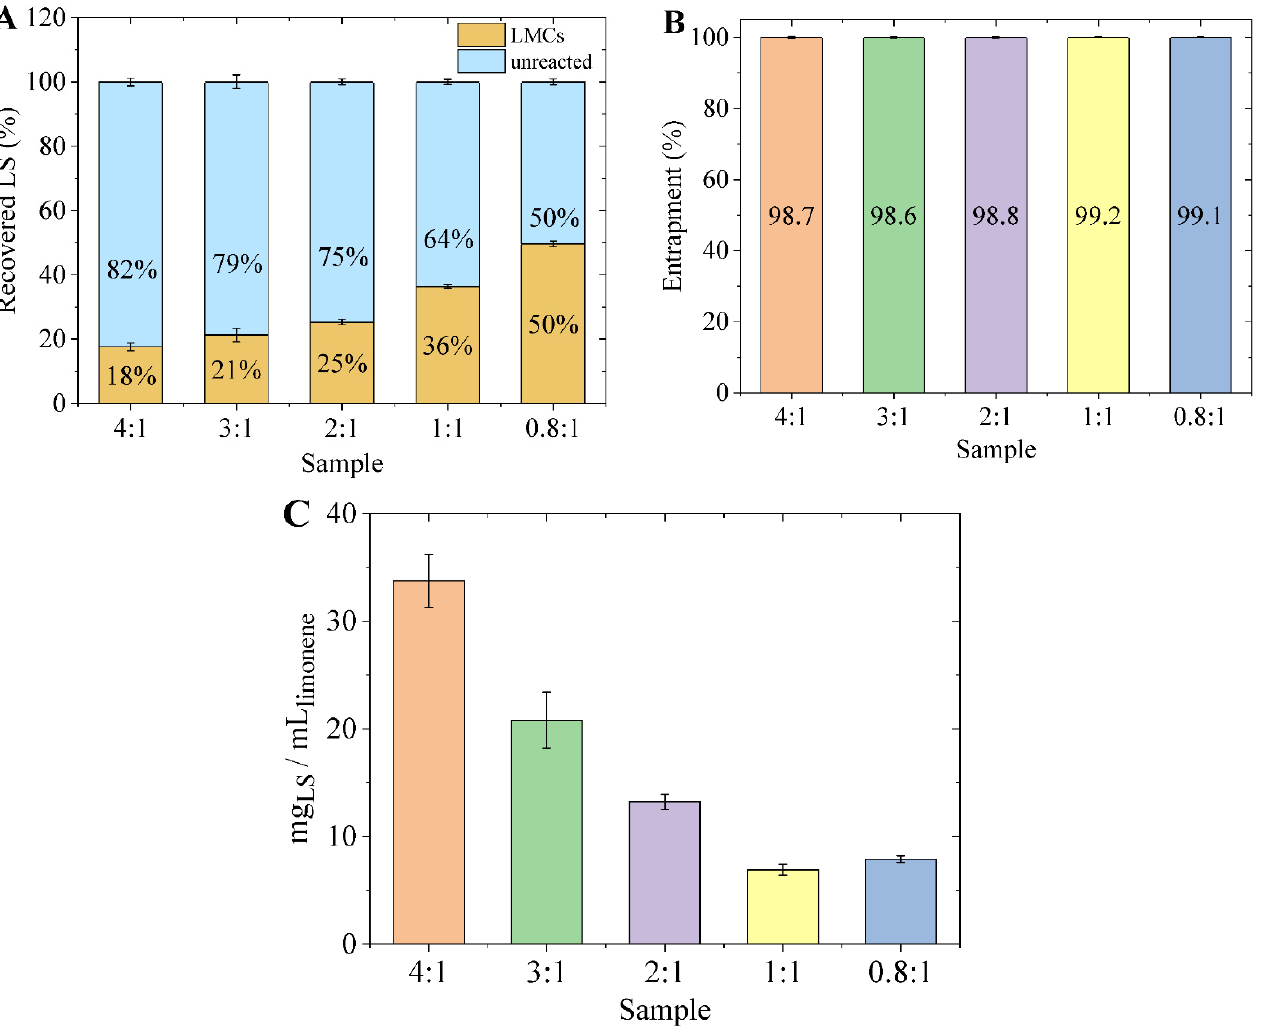
Figure 3. ( A ) Percentage of capsule forming SLS and of unreacted SLS; ( B ) entrapment of limonene in LMCs; ( C ) mass of SLS used per volume of limonene.